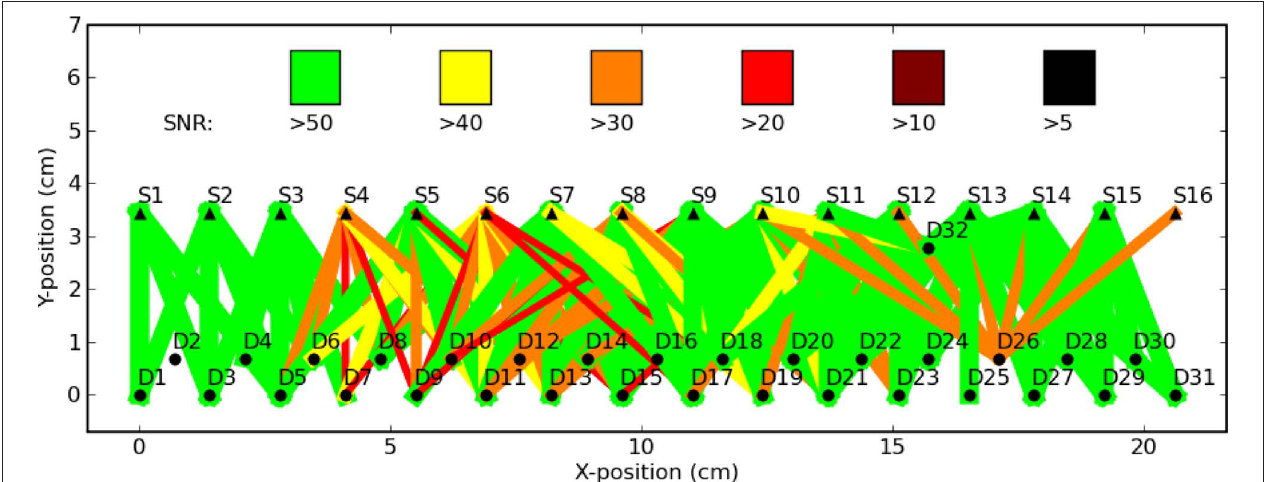
connected with progressively darker lines. Sources or detectors with few or only bad connections (e.g., S16, D25) could be candidates for pruning. Regions of red colors indicate reduced sensitivity relative to other regions, as seen in the vicinity of sources S4 and S6.